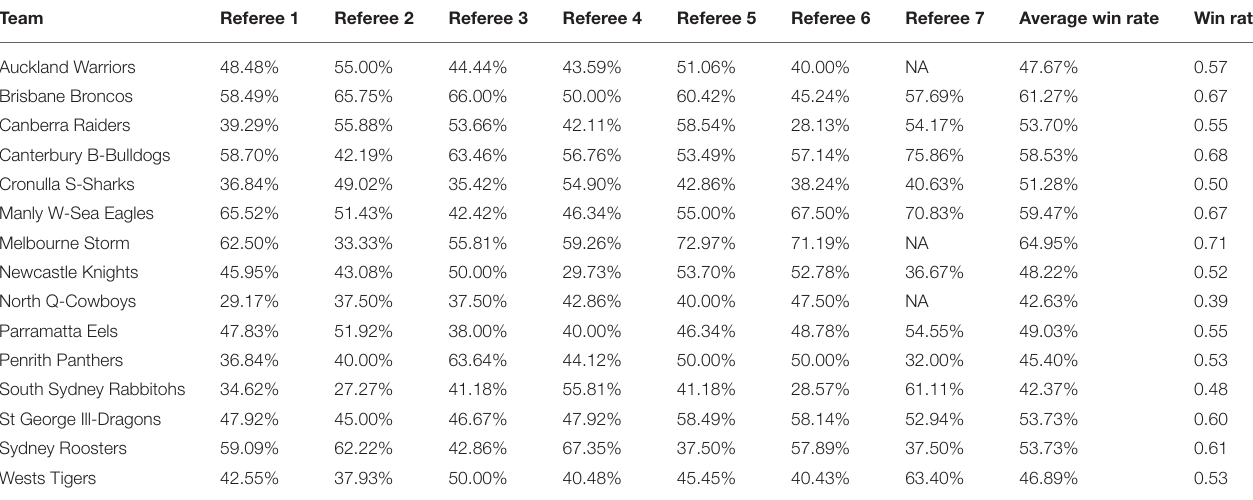
TABLE 2 | Winning percentages for NRL teams under different leading professional NRL referees.